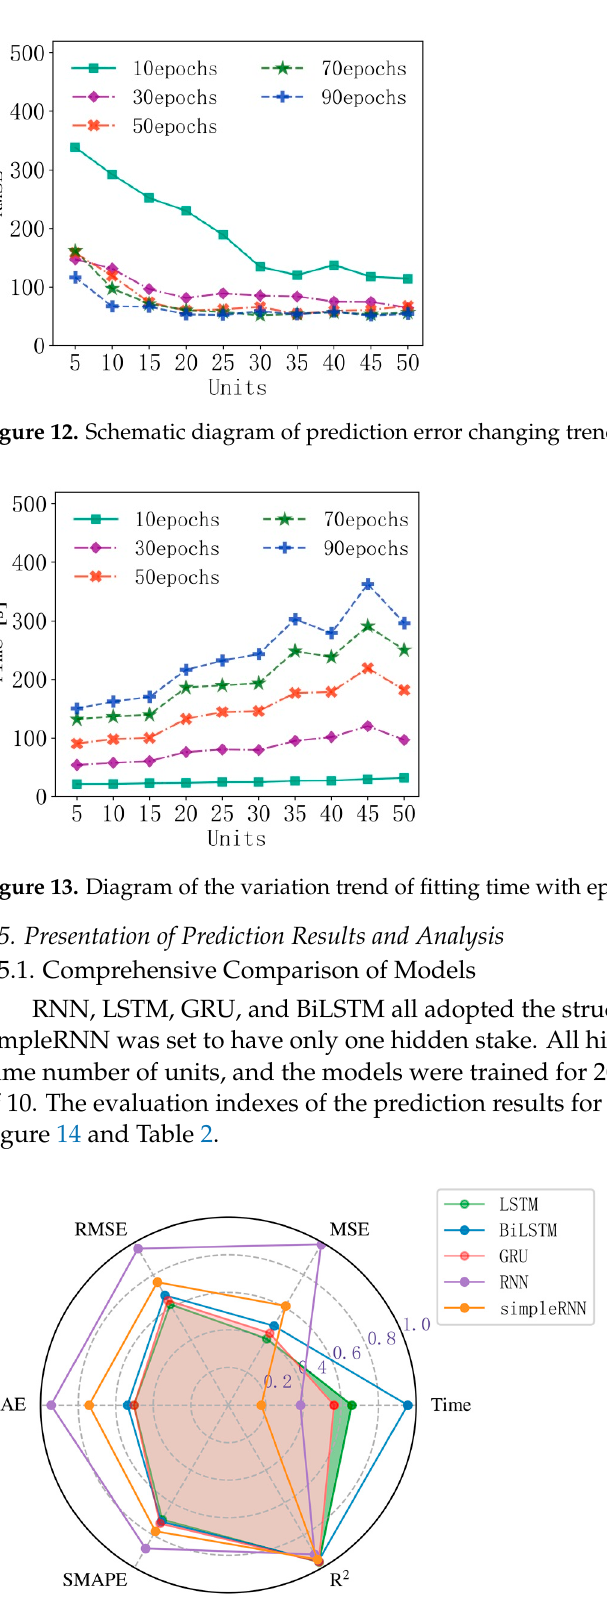
Table 2. Performance comparison of basic neural network models.